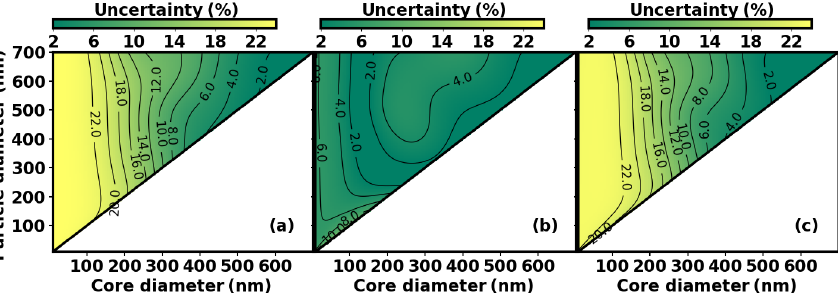
Figure 7. Uncertainty in the MAC of BC when (a) the real part of the RI ranges from 1.5 to 2.0 and the imaginary part ranges from 0.5 to 1.1, (b) the real part of the RI ranges from 1.5 to 2.0 and the imaginary part is fixed at 0.8 and (c) the real part of the RI is fixed at 1.75 and the imaginary part ranges from 0.5 to 1.1. The bold black solid line is the 1 : 1 line and presents the uncertainty of the MAC for pure BC particles with different RIs.